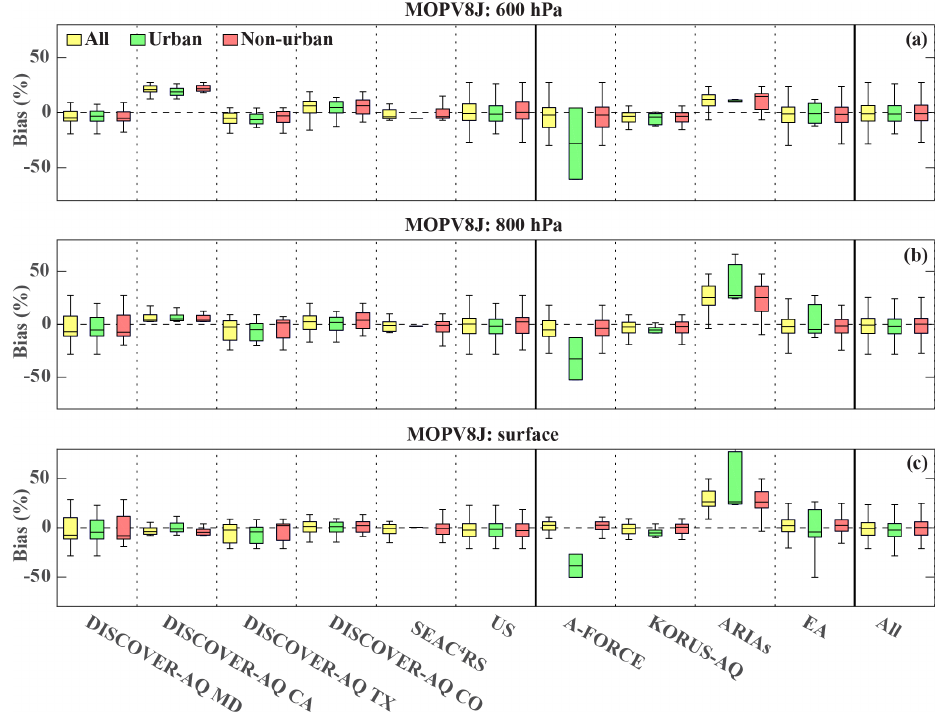
Figure 6. Box plot (with medians represented by middle bars, interquartile ranges between 25th and 75th percentiles represented by boxes, and the most extreme data points not considered outliers represented by whiskers) for biases (%) for the profiles over both urban and non- urban regions (yellow), profiles over urban regions (green), and profiles over non-urban regions (red) at 600hPa layer (a) , 800hPa layer (b) , and the surface layer (c) . An outlier is a value that is more than 1.5 times the interquartile range away from the top or bottom of the